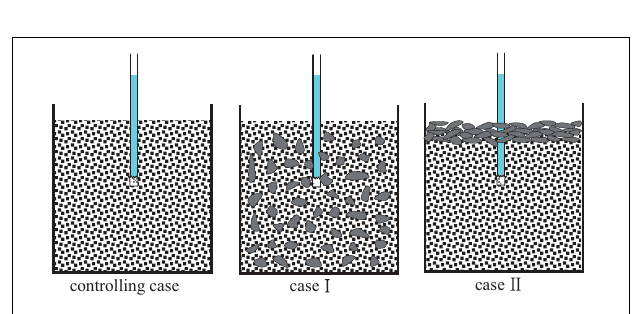
FIGURE 6 | Test operation mode.